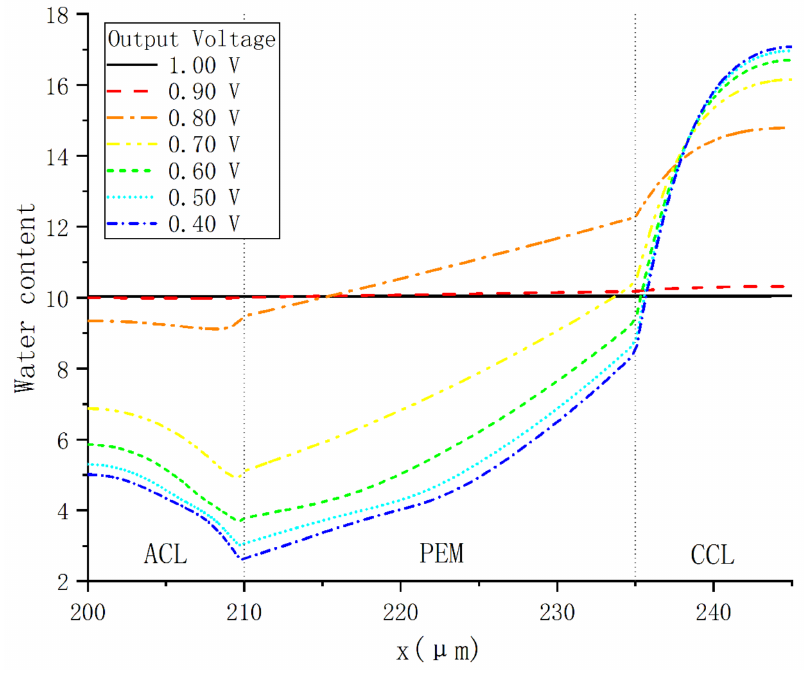
Figure 7. Water content distribution under various operating